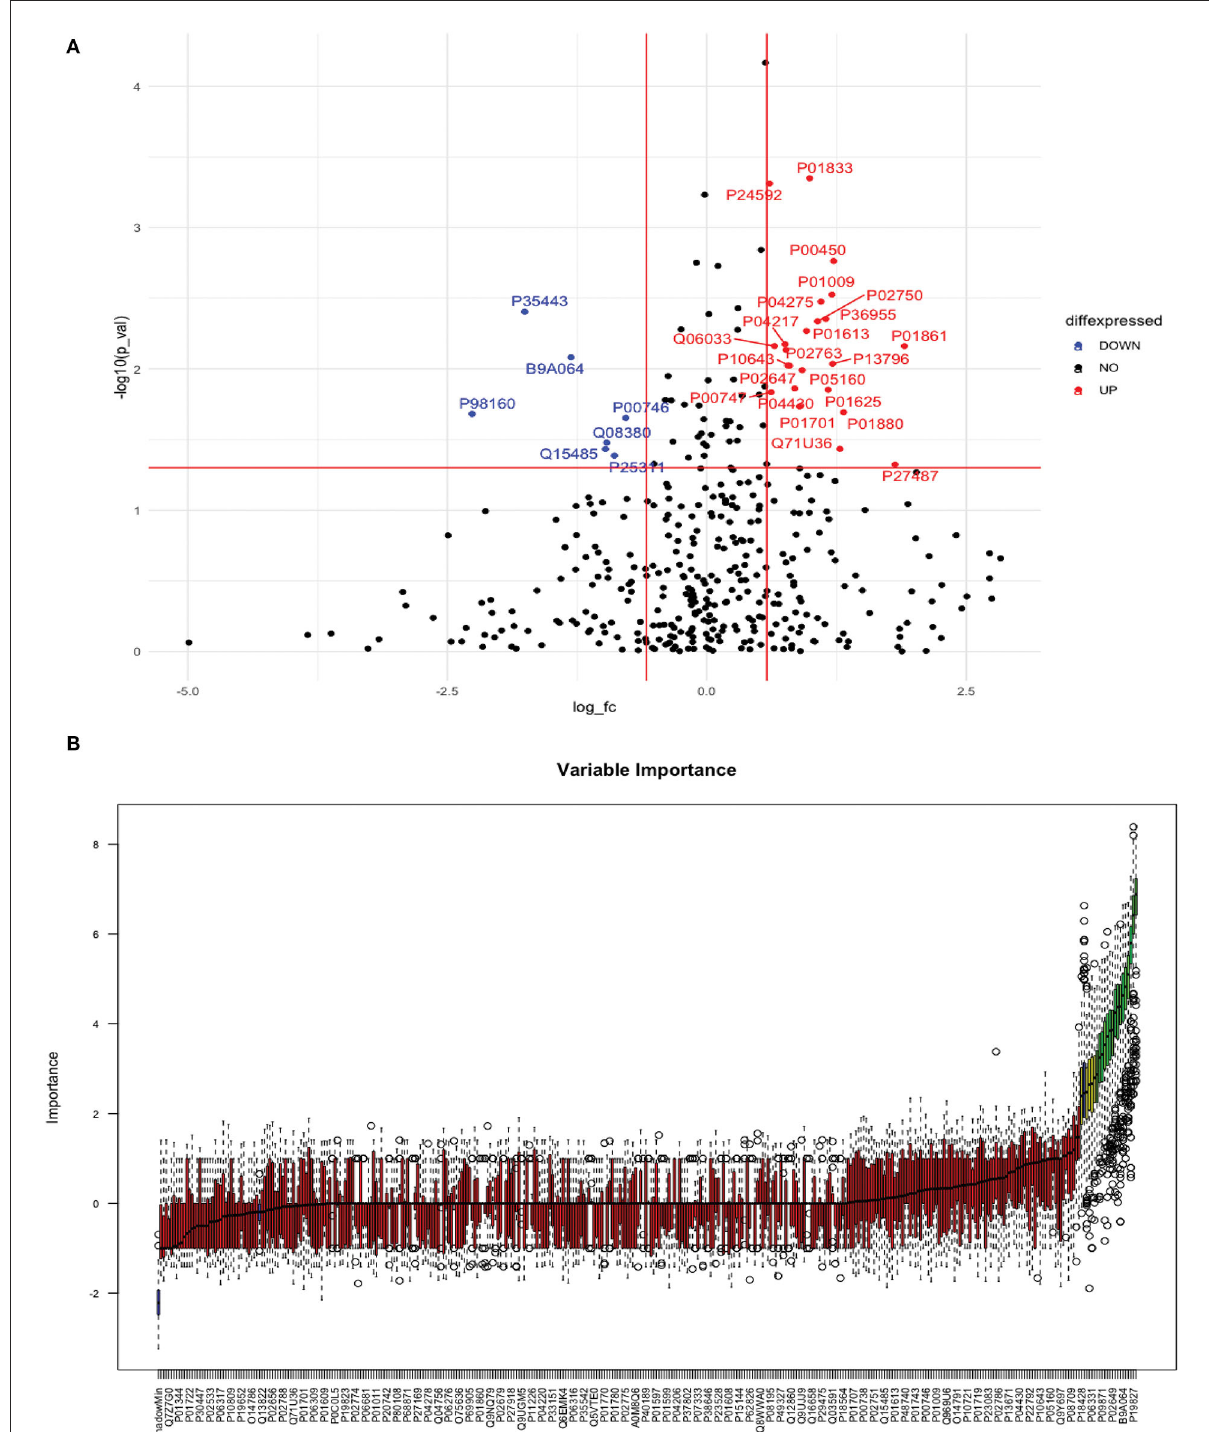
FIGURE8 (A) Volcano plot depicting the log2 fold change on the x-axis and –log10 p- value on the y-axis for the upregulated and downregulated proteins in 20 ICH cases compared to 20 healthy controls. (B) Feature selection using the Boruta random forest depicting important features/proteins to differentiate 20 ICH and 20 healthy